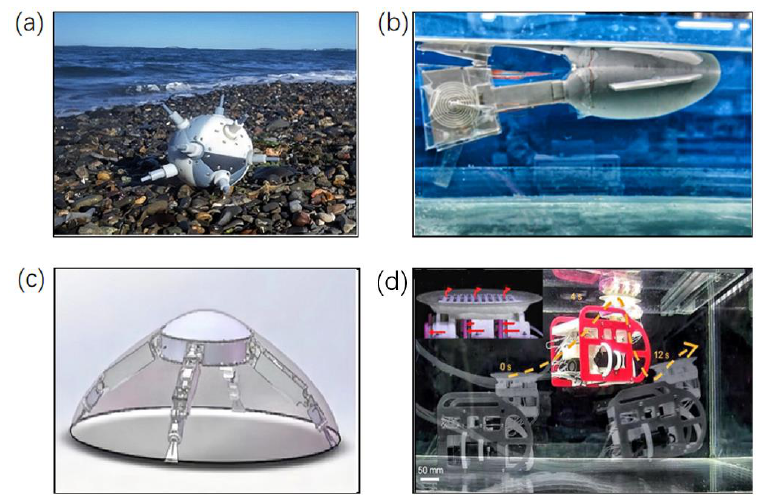
Figure 9. ( a ) Bionic sea urchin robot [127]. ( b ) Schematic diagram of a 3D fish model [128]. (c) Bionic jellyfish robot [129]. (d) The biomimetic remora adhesive disc prototype [130].